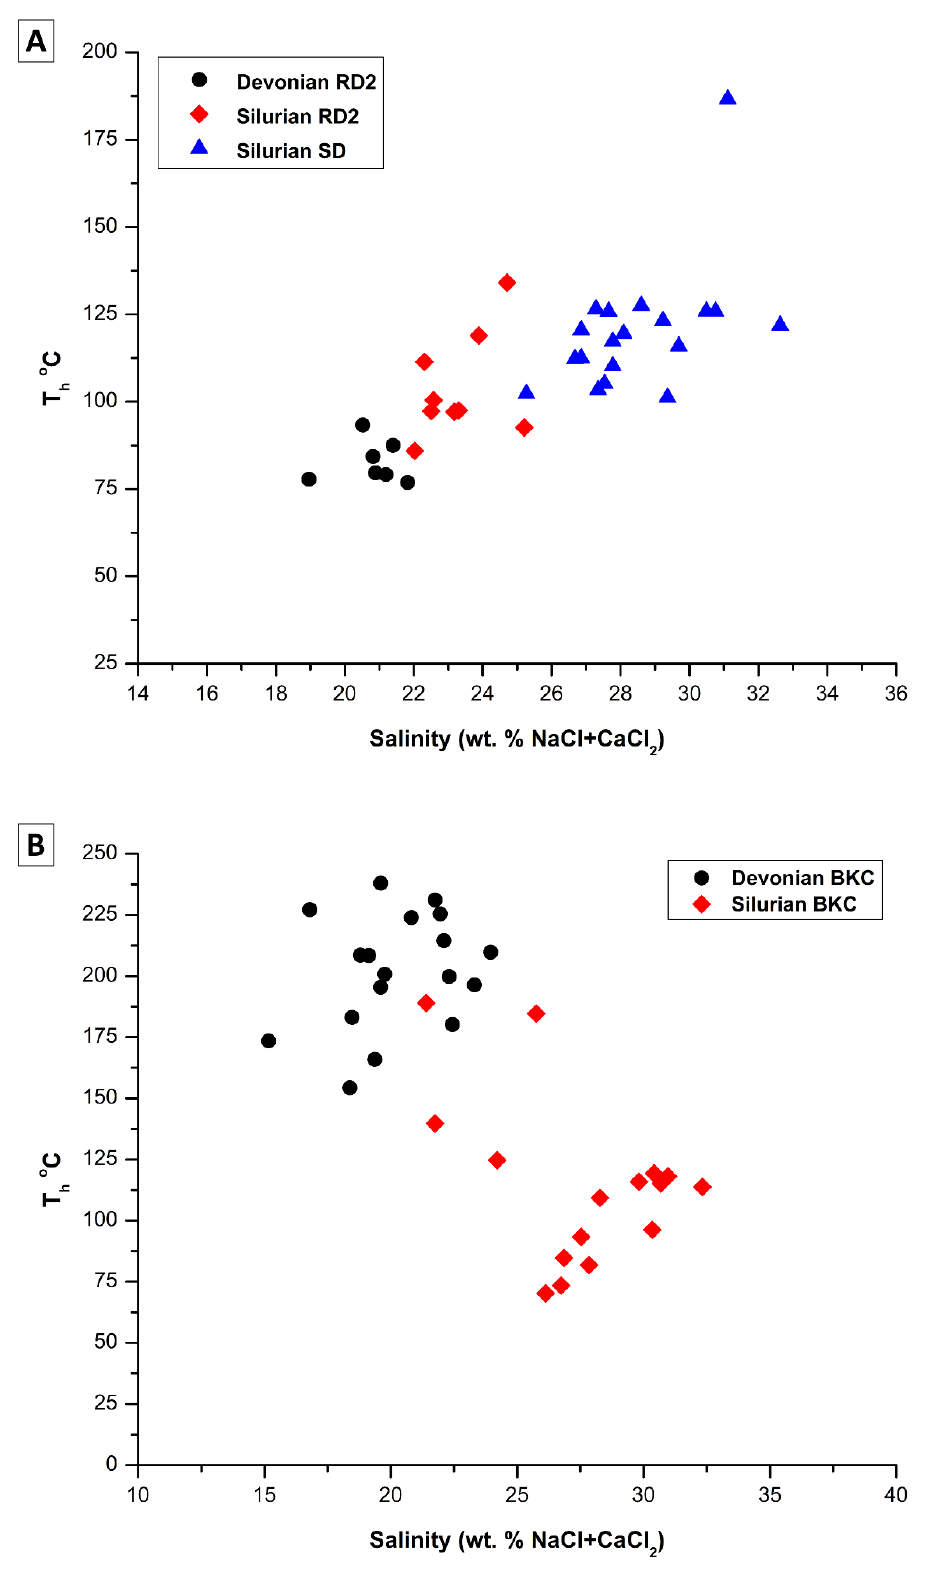
Figure 14. Homogenization temperature vs. salinity cross plots for analyzed ( A ) dolomite and ( B ) calcite phases.